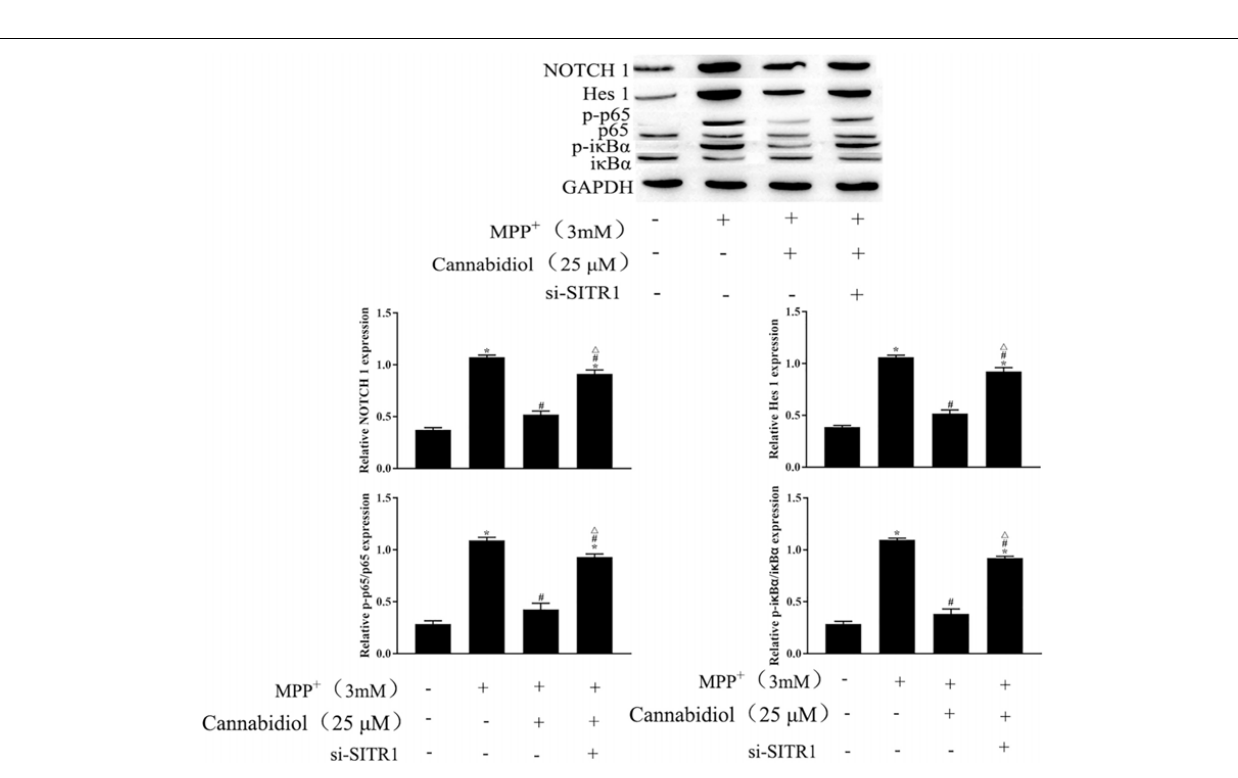
Frontiers in Cellular Neuroscience |